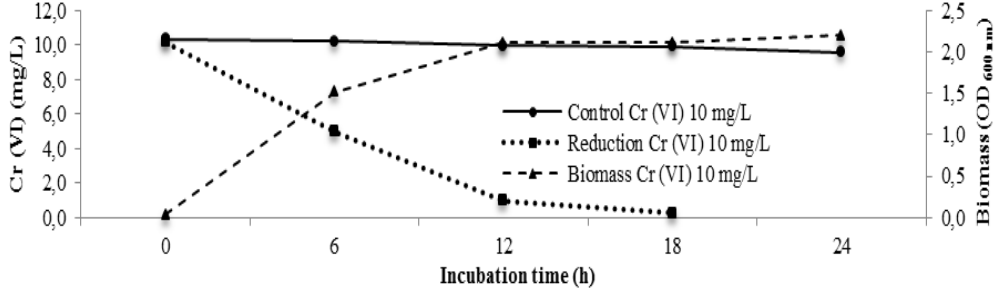
Fig. 3. Reduction capacity of Enterobacter sp. HT1 at 10 mg /L of Cr (VI)